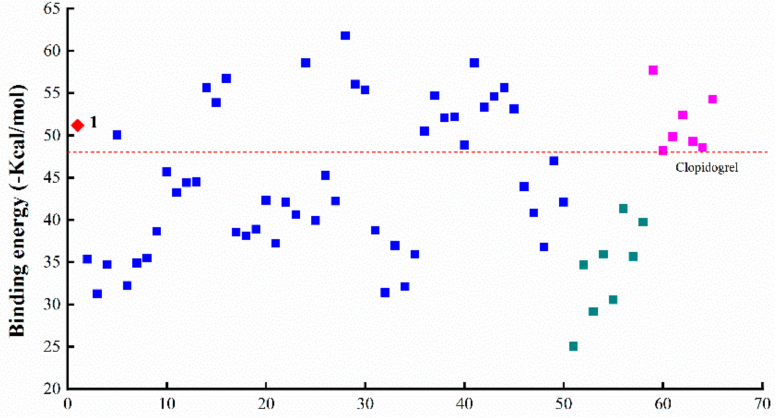
Figure 2. Binding energy of the interactions between ZO-1 and miscellaneous ligands ( ◆ colchicine, ■ colchicine analogues, ■ intestinal injury compounds, ■ intestinal protective compounds).